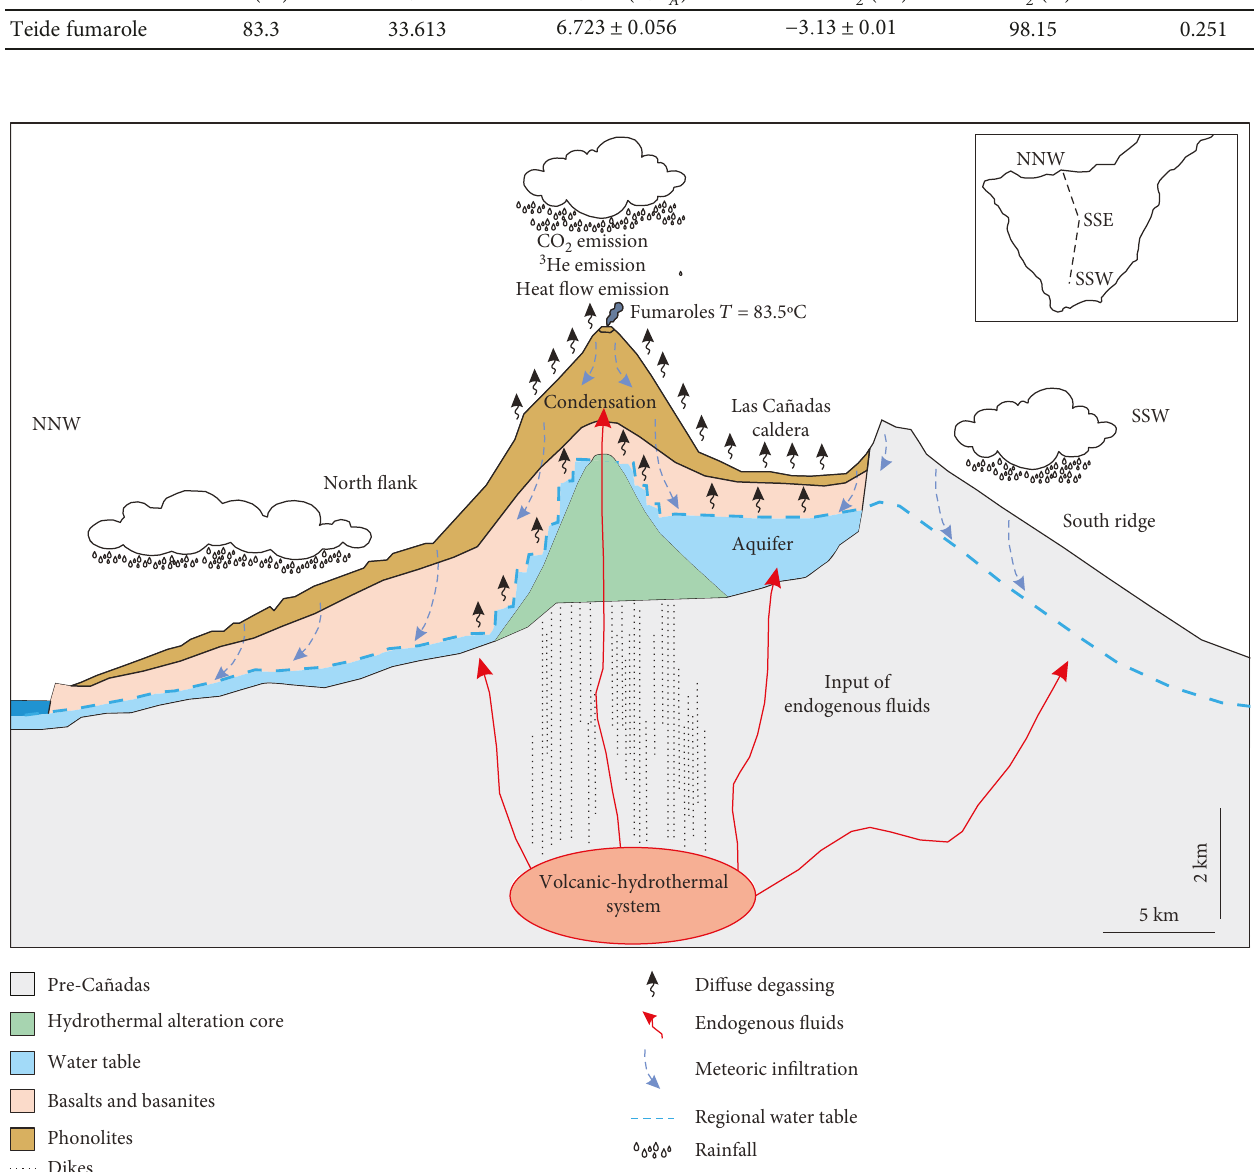
Table 1: Outlet temperature, chemical, and isotopic composition of fumarolic gases from the summit crater of Teide volcano. T ( ° C)